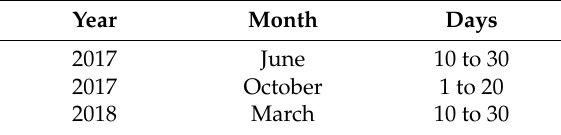
Table 2. Periods considered in the AMESIS